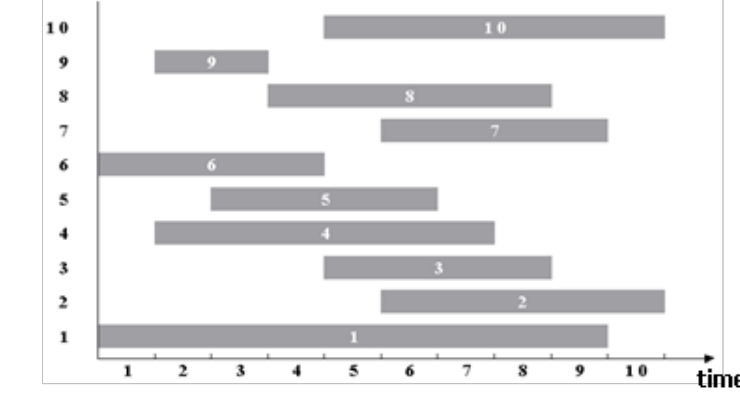
Fig. 2 Graph representation of transactions in example 1.